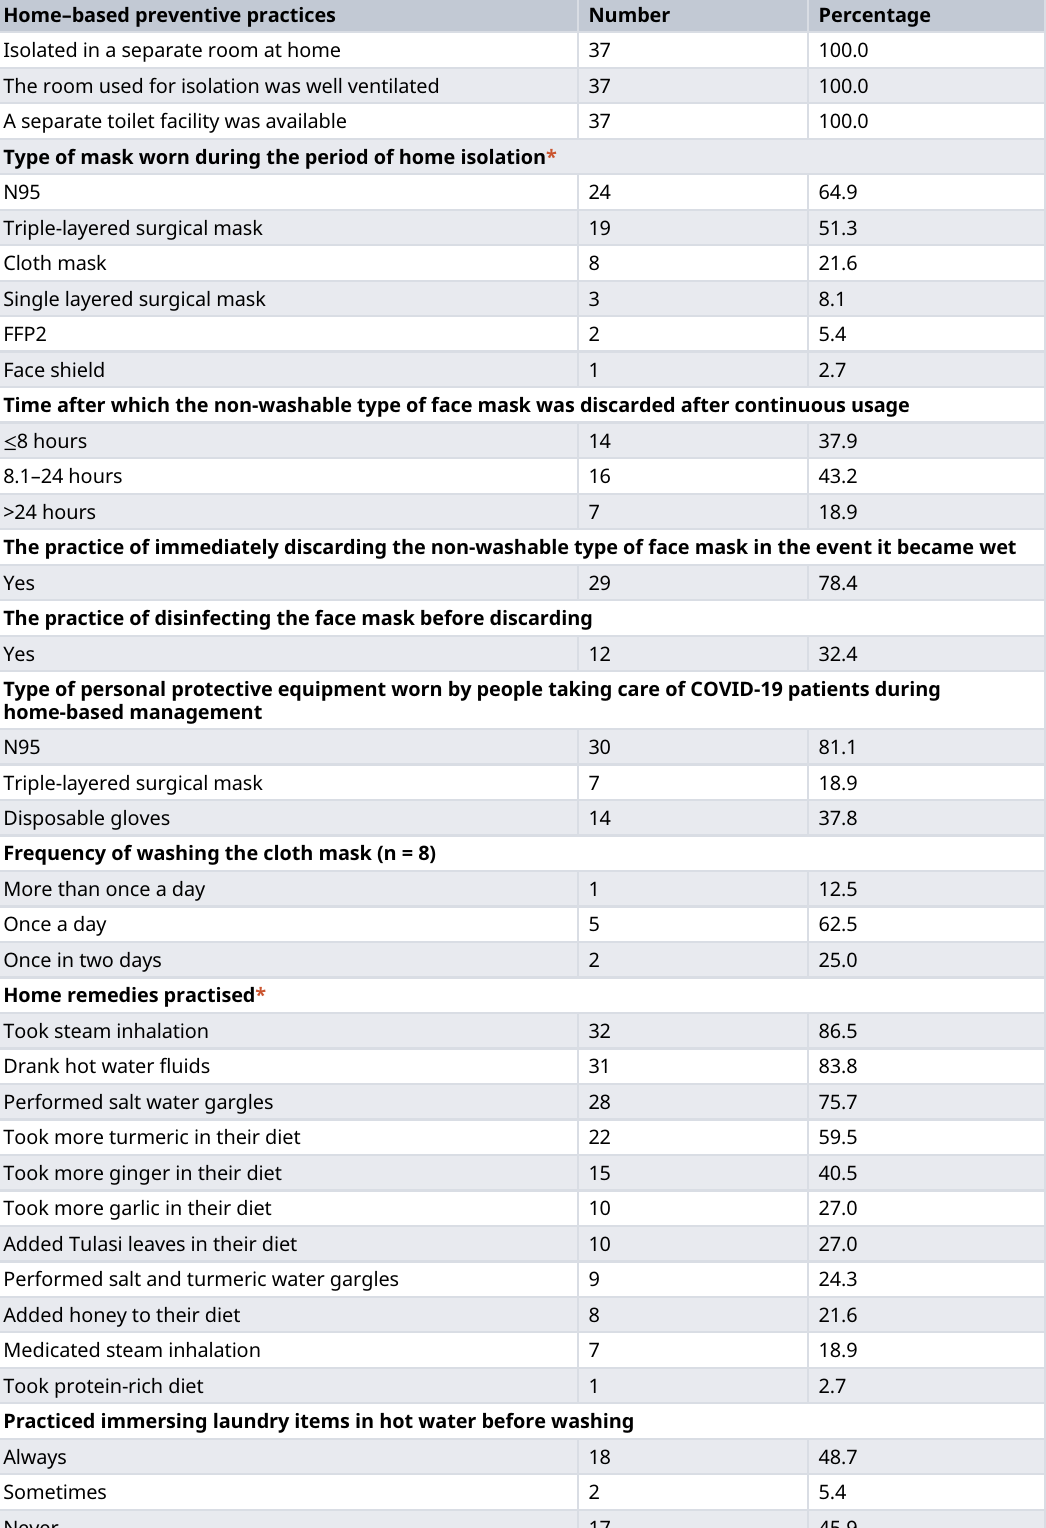
Table 3. Home-based preventive care practices among participants who were diagnosed with COVID-19. Home – based preventive